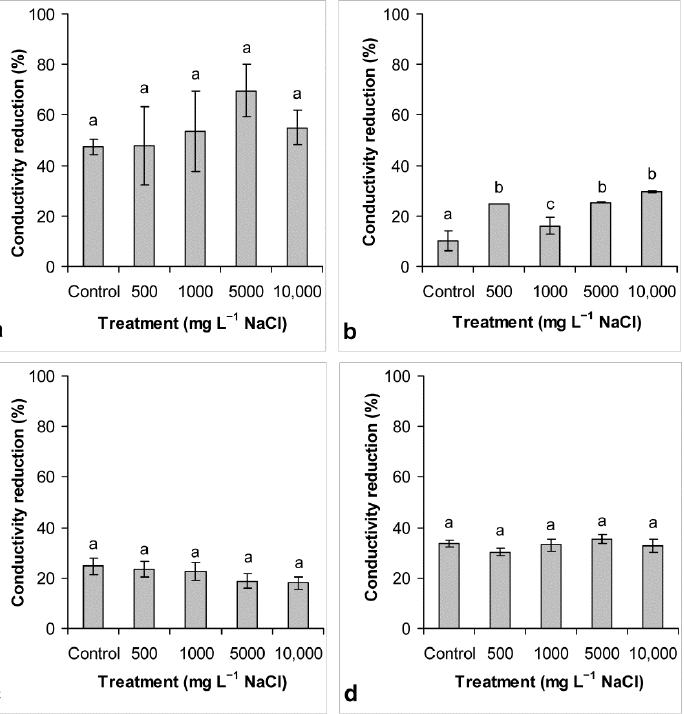
Figure 4. Conductivity reduction (%) of control and NaCl-treated Coelastrum morus cultures in: ( a ) HC-LR; ( b ) HC-HR; ( c ) LC-HR and ( d ) LC-LR media. HC: higher content; LC: lower content; HR: higher ratio; LR: lower ratio. Mean values ( n = 3) and standard deviations are plotted. Significant differences ( p < 0.05) are indicated by different lowercase letters.